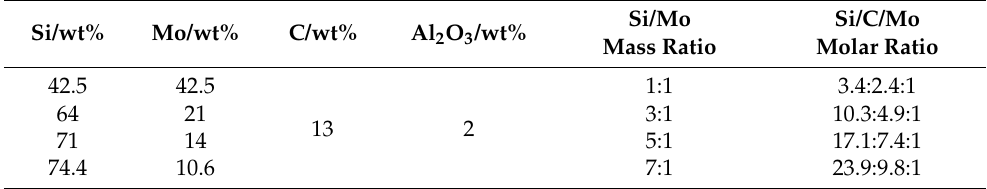
Table 1. Detailed composition of the powder used in the second pack cementation process.